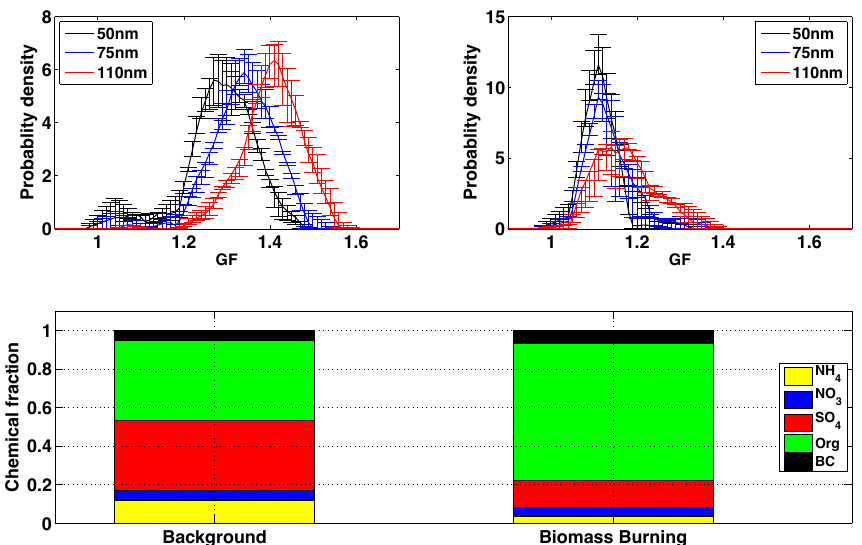
Fig. 4. The upper panel presents the growth factor probability density functions for the two distinct periods selected for the case studies (left panel: background; right panel: biomass-burning) for 50nm, 75nm and 110nm-sized particles. The lower panel illustrates the mass fractions of different aerosol components during these periods obtained from AMS and aethalometer measurements. Note that during the biomass-burning period there were unfortunately too few data points for 50nm and 110nm-sized particles to conclude anything about the size-dependency of aerosol